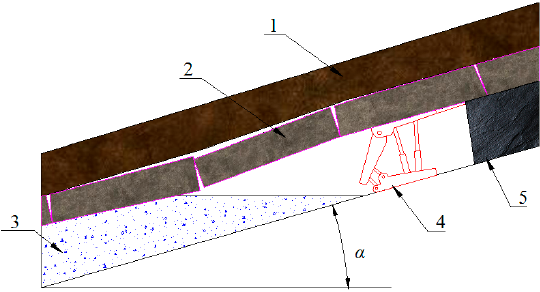
Figure 2. Schematic Diagram of an Open-type Backfilling of SCM. 1-main roof; 2-immediate roof; 3- backfilled body; 4-hydraulic support; 5-coal body; α -coal bed pitch.